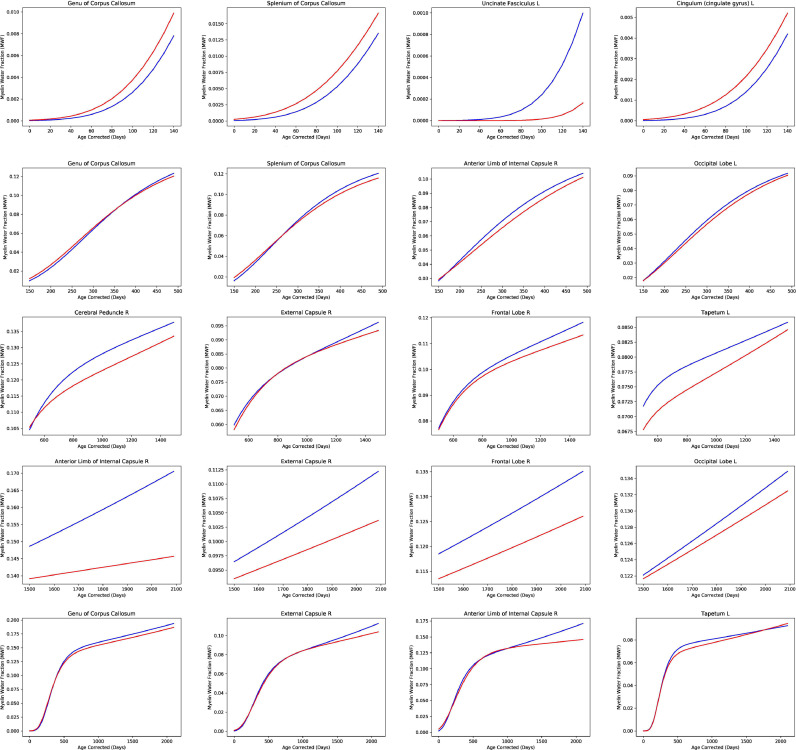
Reconstructed longitudinal MWF trajectories from a representative subset of the examined brain areas. Carrier trajectories are denoted in red, while noncarrier trajectories are displayed in blue. Widespread differences in the trajectories of development were observed between carriers and non-carriers. First row shows differences in the β parameter between ε4 carriers and non-carriers; the second row shows differences in the γ parameter; the third row shows differences in the α parameter; and the fourth row shows differences in η parameter. The figure rows are arranged in chronological order of myelin development events. The last row in the figure shows the overall myelin trajectories for both genotype groups. See Supplementary Table 1 for a complete comparison of the model parameters between ε4 carriers and non-carriers.